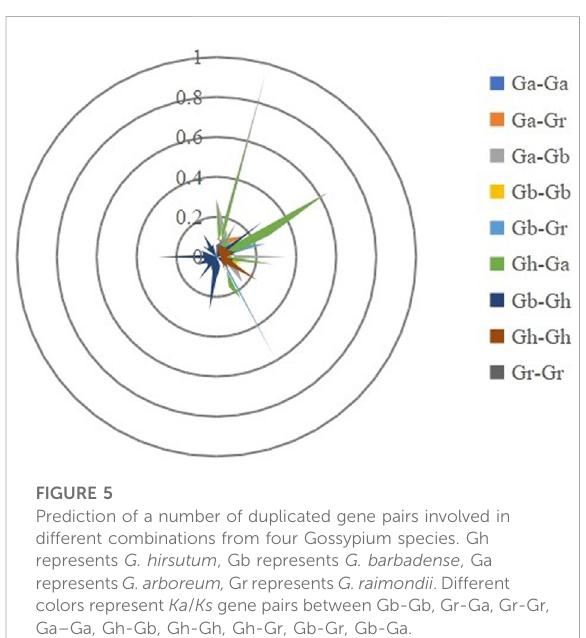
FIGURE 5 Prediction of a number of duplicated gene pairs involved in different combinations from four Gossypium species. Gh represents G. hirsutum , Gb represents G. barbadense , Ga represents G.arboreum, Grrepresents G.raimondii .Different colors represent Ka / Ks gene pairs between Gb-Gb, Gr-Ga, Gr-Gr, Ga – Ga, Gh-Gb, Gh-Gh, Gh-Gr, Gb-Gr, Gb-Ga.